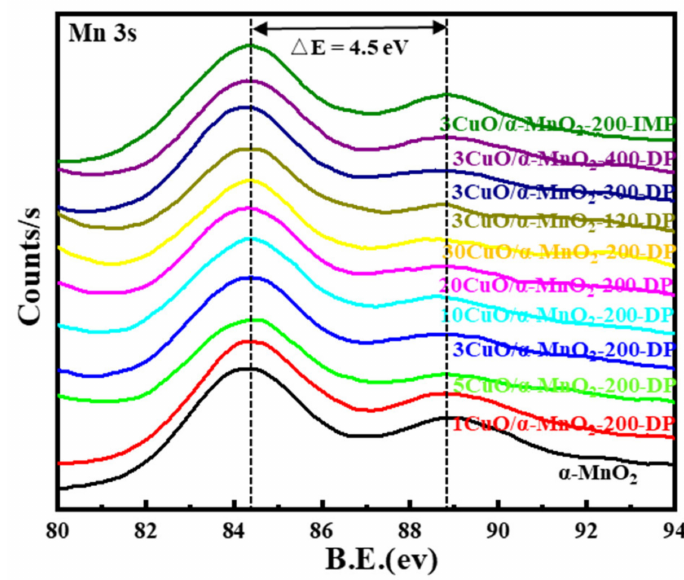
Figure 7. XPS spectra of Mn 3s for